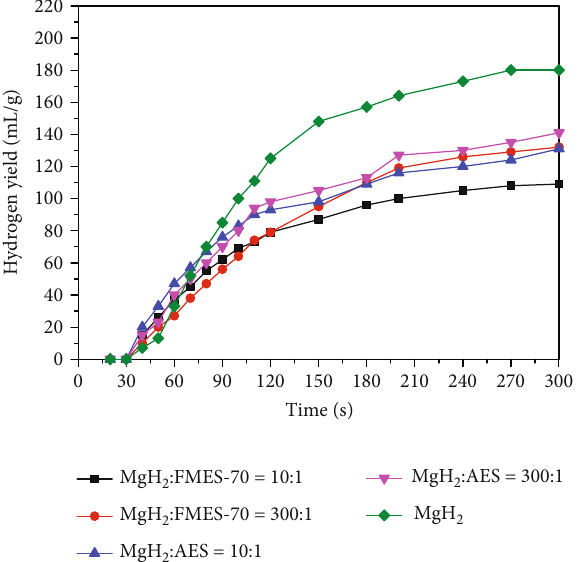
Figure 2: The e ff ect of di ff erent SDBS dosages on hydrogen Table 1: Surface tension values of aqueous solutions with di ff erent SDBS dosages.